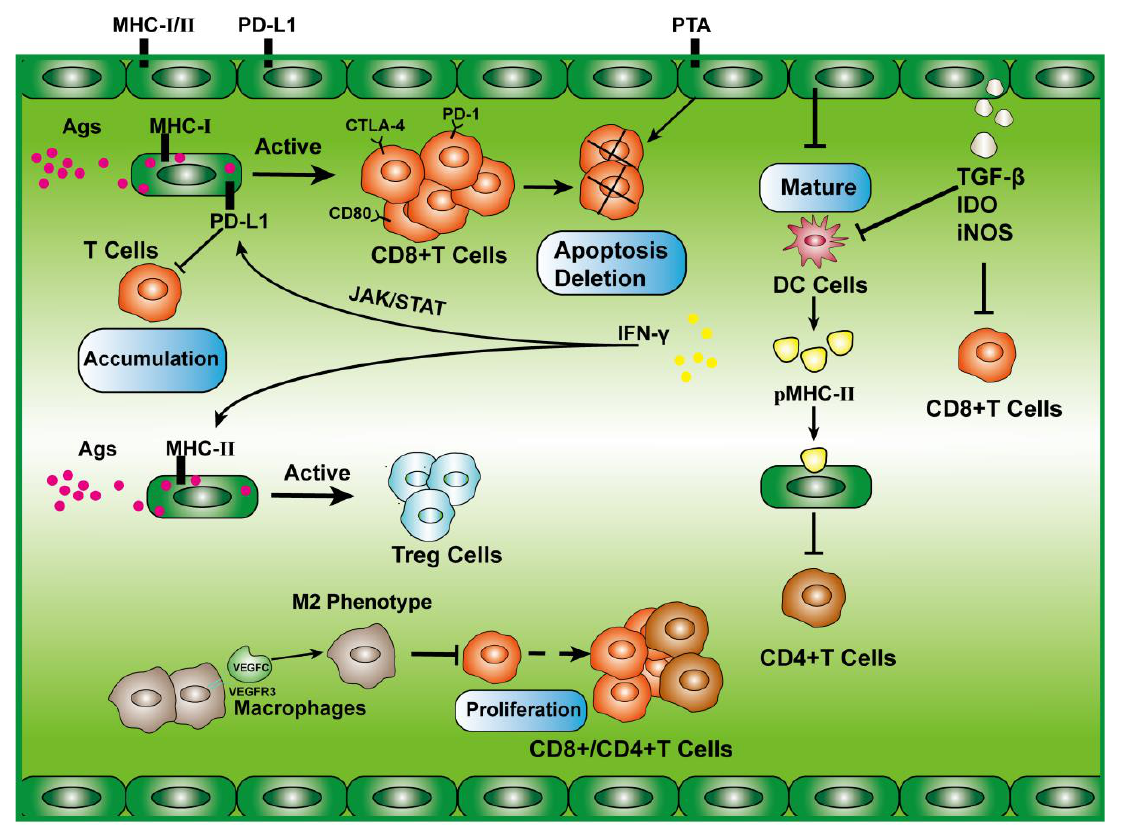
Figure 4. Mechanisms of immune tolerance mediated by the lymphatic system. IFN- γ signaling promotes the expression of MHC-I molecules and PD-L1 by LECs, which present immune checkpoints such as CTLA-4, PD-1, and CD80 expressed by CD8 + T cells activated by foreign antigens. These CD8 + T cells undergo apoptosis. LECs expressing PTA also result in the loss of CD8 + T cells. LECs secrete immunosuppressive molecules such as TGF- β, IDO, and INOS to inhibit CD8 + T cells and DCs. LECs can inhibit DC maturation. Presentation of antigens by LECs expressing MHC-II activates Treg cells and inhibits effector T cells. The expression of VEGFR3 by macrophages and VEGFC can promote the polarization of macrophages to the M2 type, and M2-type macrophages can inhibit the proliferation of effector T cells. LNSCs obtain pMHC-II from DCs to inhibit CD4 + T